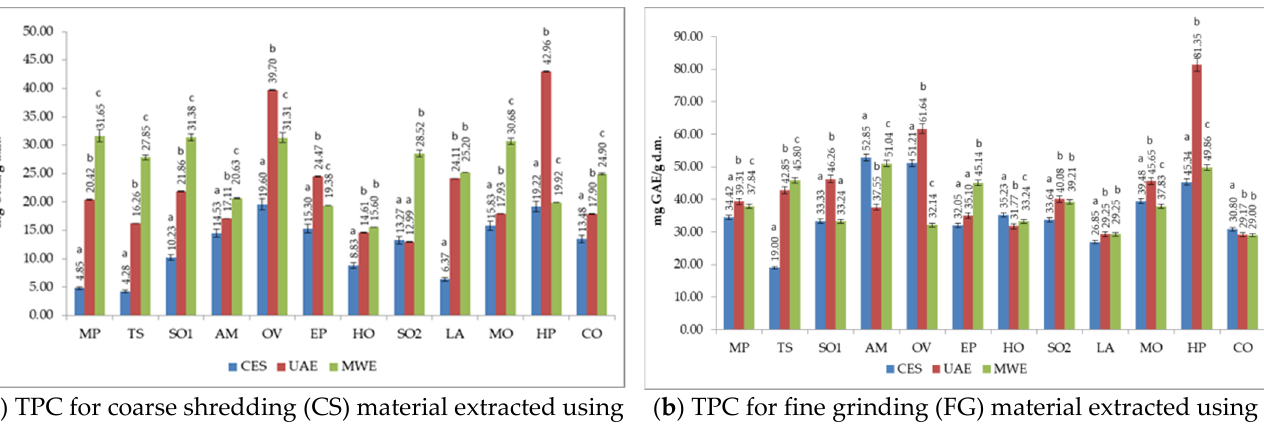
Figure 3. The TPC compared for the 3 extraction methods ( a ) CS, ( b ) FG. According to the t − test, the different lower-case letters (a–c) represent the significant differences ( p < 0.05) between samples from the same plant obtained by different extraction methods.